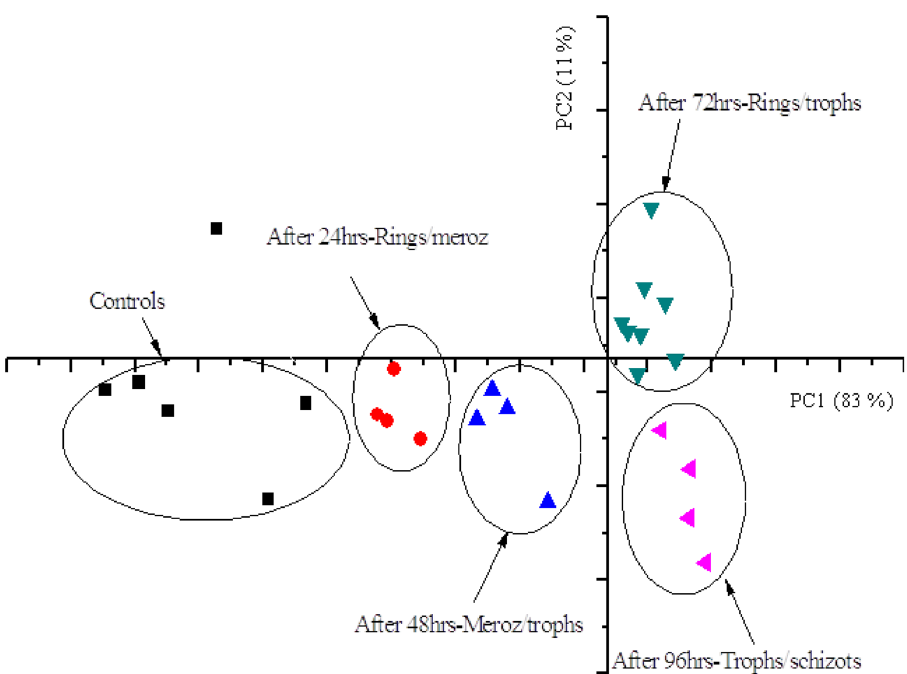
Figure 5. PCA score plot for cultured blood based on spectral features of the analyzed